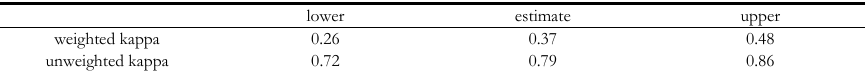
Cohen Kappa and Weighted Kappa correlation coeffcients and confidence boundaries of METAVIR vs